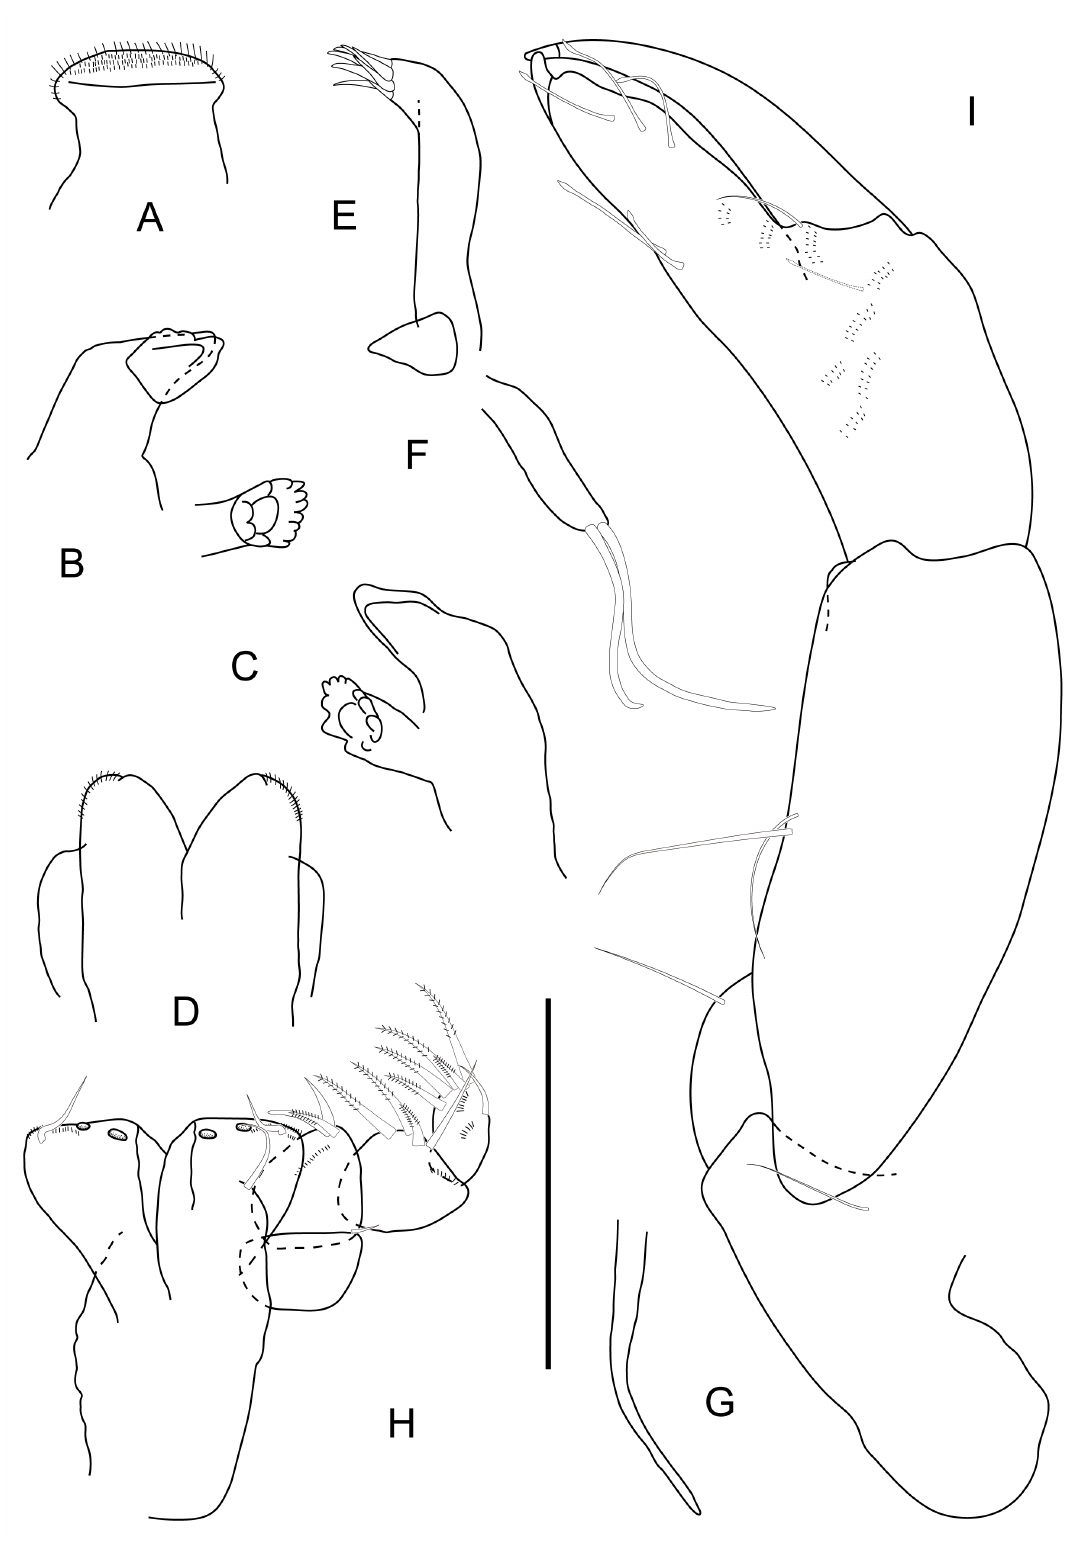
Fig. 15. Typhlotanais priscilae sp. nov., ♀, dissected (MZUSP 38009). A . Labrum. B . Left mandible. C . Right mandible. D . Labium. E . Maxillule. F . Maxilla. G . Epignath. H . Maxilliped. I . Cheliped. Scale bar = 0.1